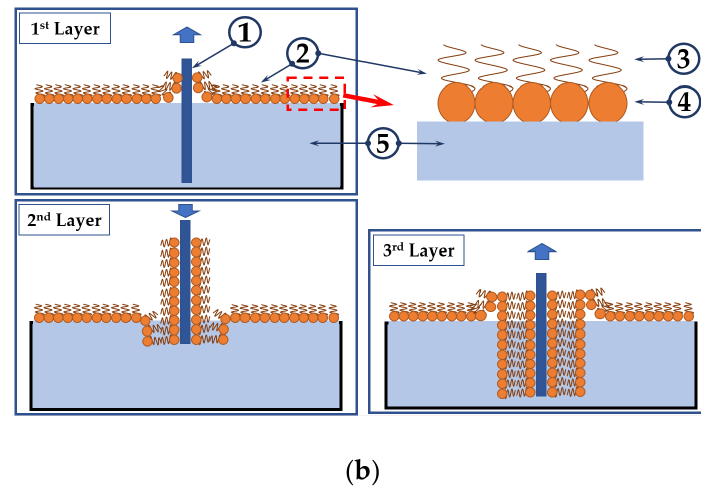
Figure 1. ( a ) Isotherm of compression of a monolayer of arachidic (1) and stearic (2) acids; ( b ) a schematic representation of the process of transferring a monolayer onto a solid substrate: (1) sub- strate, (2) AA or SA monolayer, (3) hydrophobic and (4) hydrophilic parts of AA or SA molecules, (5) water subphase.